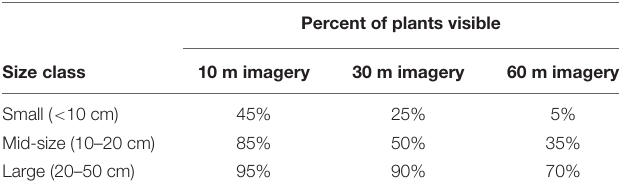
TABLE 5 | Visibility of plants in imagery collected at different flight altitudes. Plants were grouped into size classes based on their longest diameter. Percent of plants